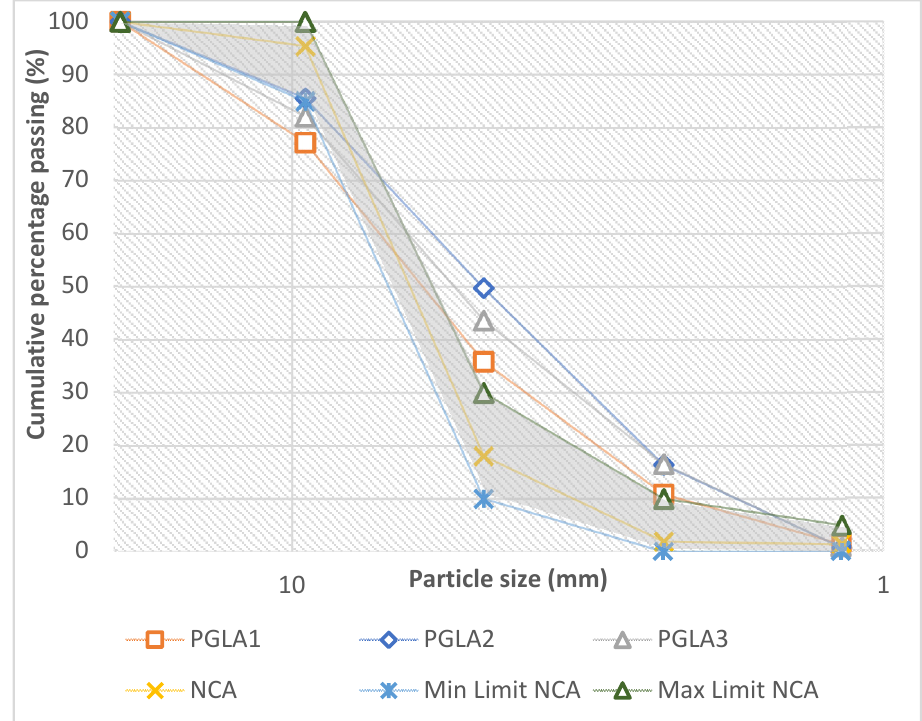
Figure 8. Particle size distribution curves for PGLAs and NCA.